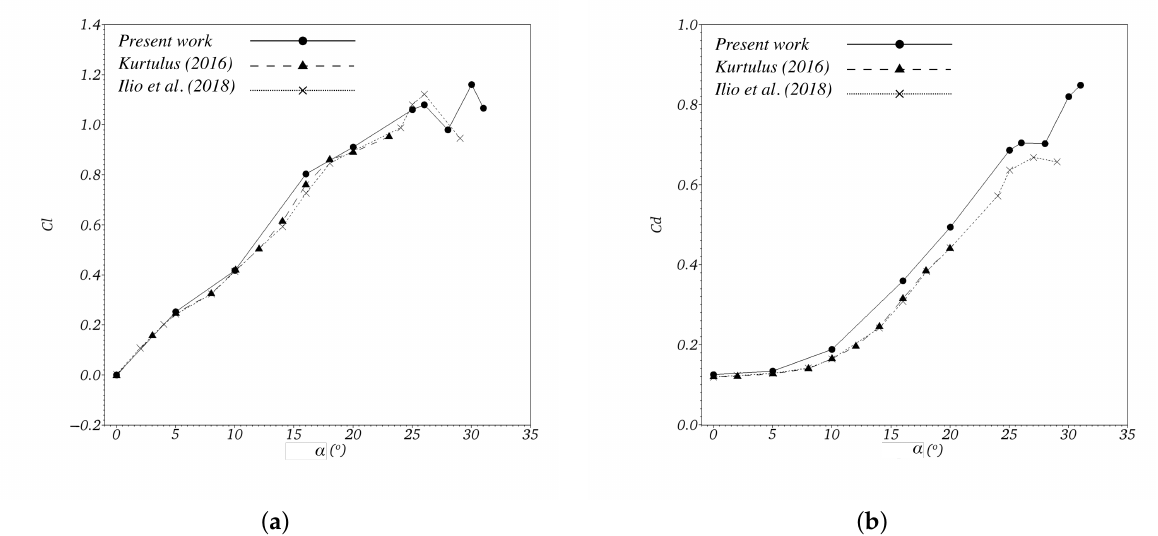
Figure 11. ( a ) Mean C l variation as a function of attack angle ( α ). ( b ) Mean C d variation as a function of the angle of attack ( α